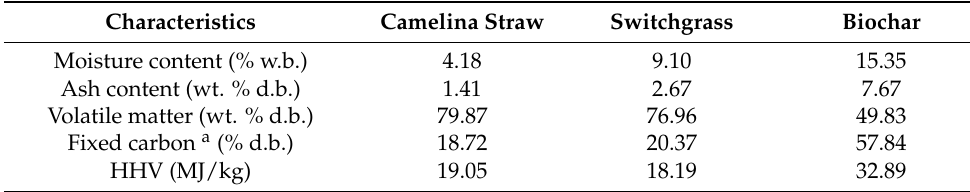
Table 1. Properties of camelina straw, switchgrass and biochar.